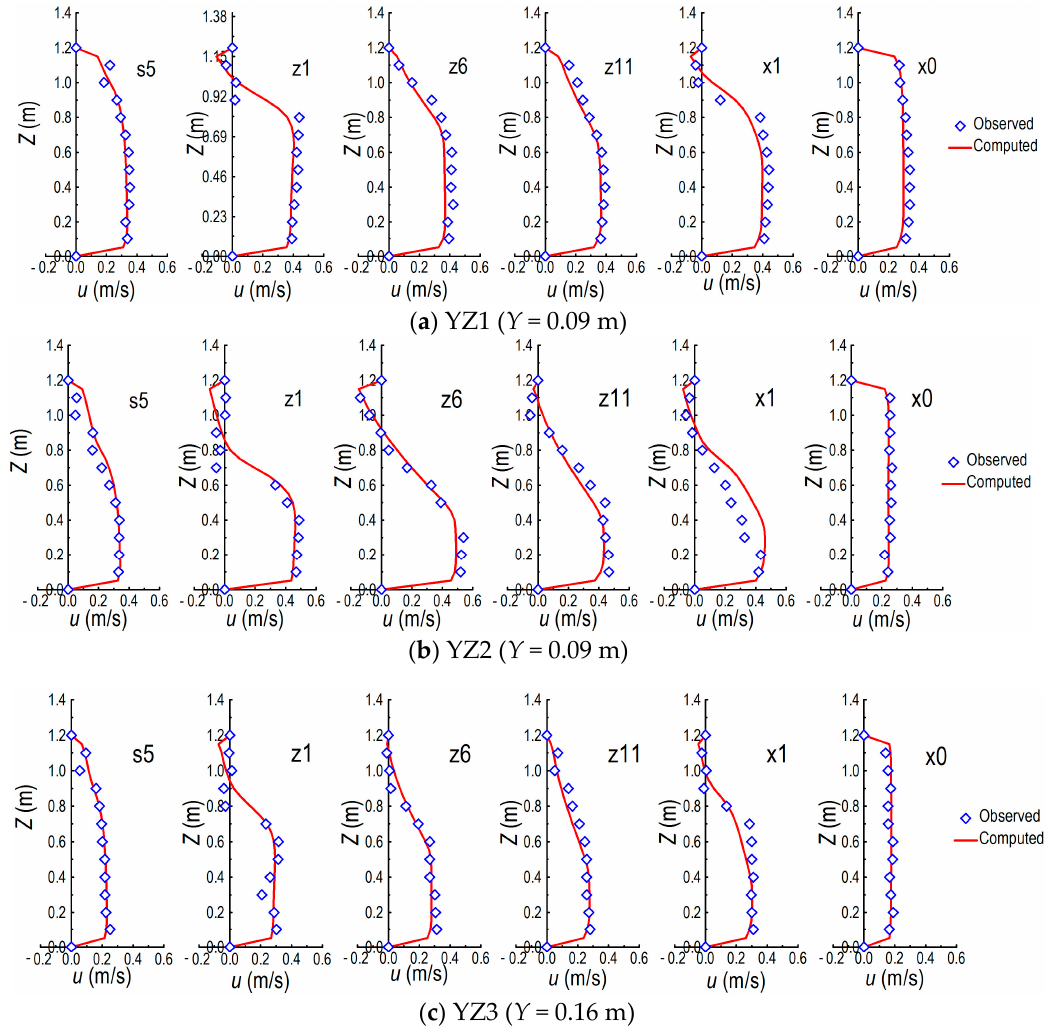
Figure 6. Comparisons of u -profiles between observed and computed data. ( a ) YZ1 ( Y = 0.09 m); ( b ) YZ2 ( Y = 0.09 m); ( c ) YZ3 ( Y = 0.16 Table 3. Comparison of R L and R W between observed and computed (spur dike 1).